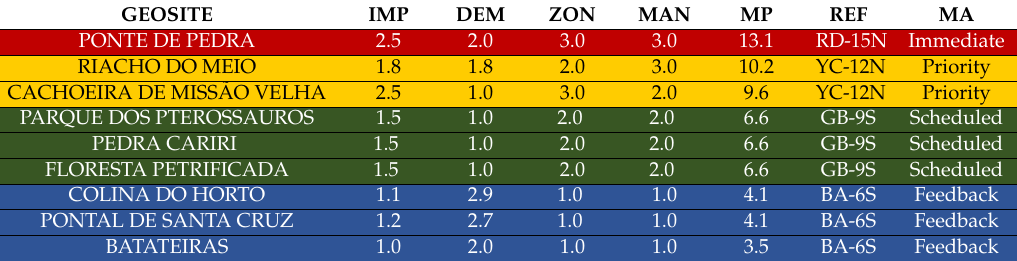
Table 7. Priority Matrix for Managing Visitation Impacts to Araripe UGGp Geosites.